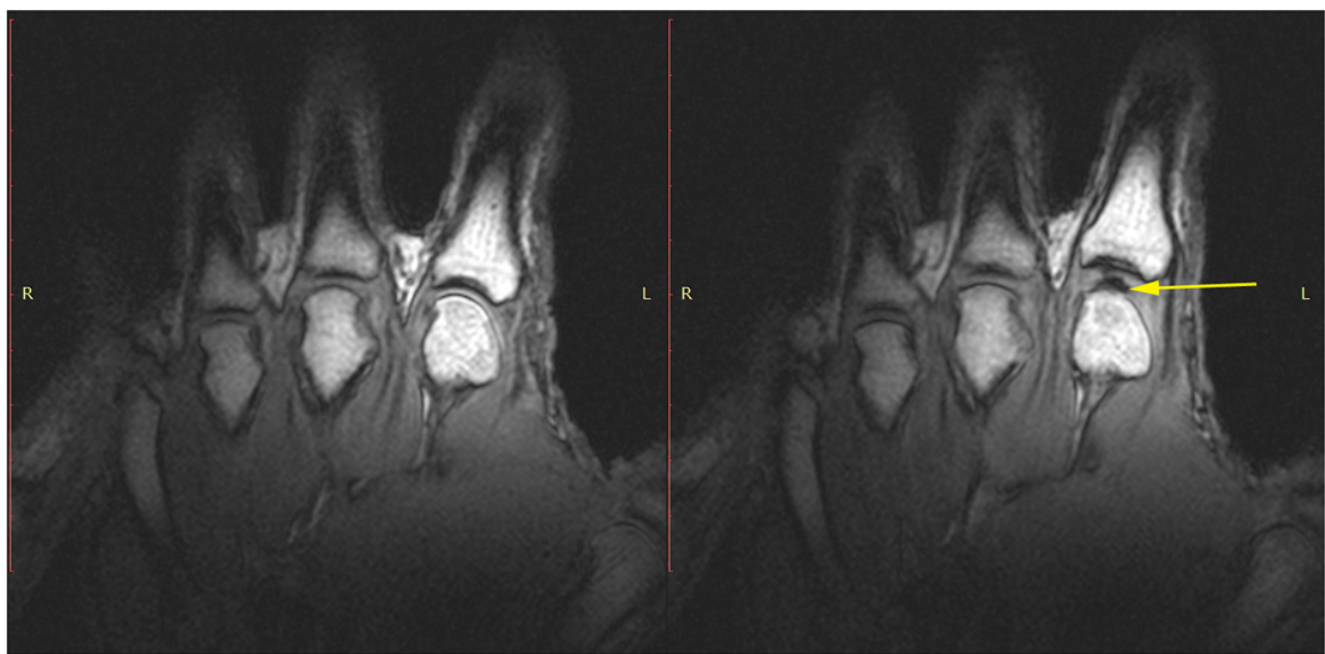
Fig 2. T1 static images of the hand in the resting phase before cracking (left). The same hand following cracking with the addition of a post-cracking distraction force (right). Note the dark, interarticular void (yellow arrow).